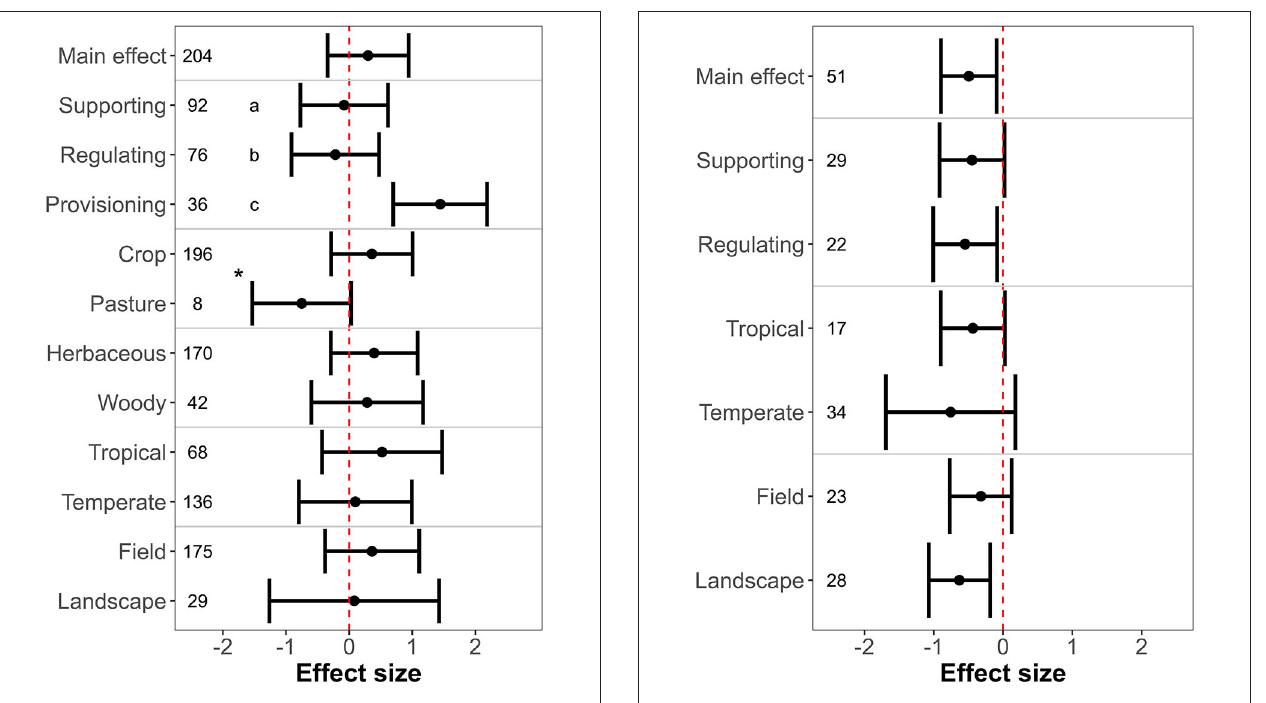
FIGURE 4 | Ecosystem services levels in farmland with hedgerows as compared to farmland without hedgerows. X-axis indicates the mean effect size (standardized mean difference) ± 95% confidence interval. The dashed vertical red line shows the null effect. A confidence interval that overlaps this line means that the effects are not significant. Significant differences between levels of moderators are indicated by asterisks (two levels) and different letters (three levels), respectively.